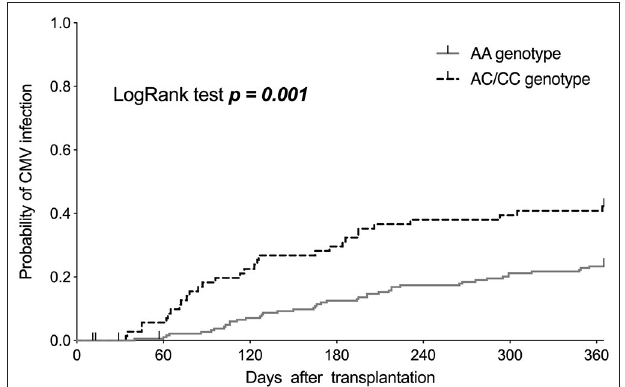
on the AA and AC/CC genotypes of the AQP5 − 1364A/C single nucleotide polymorphism.